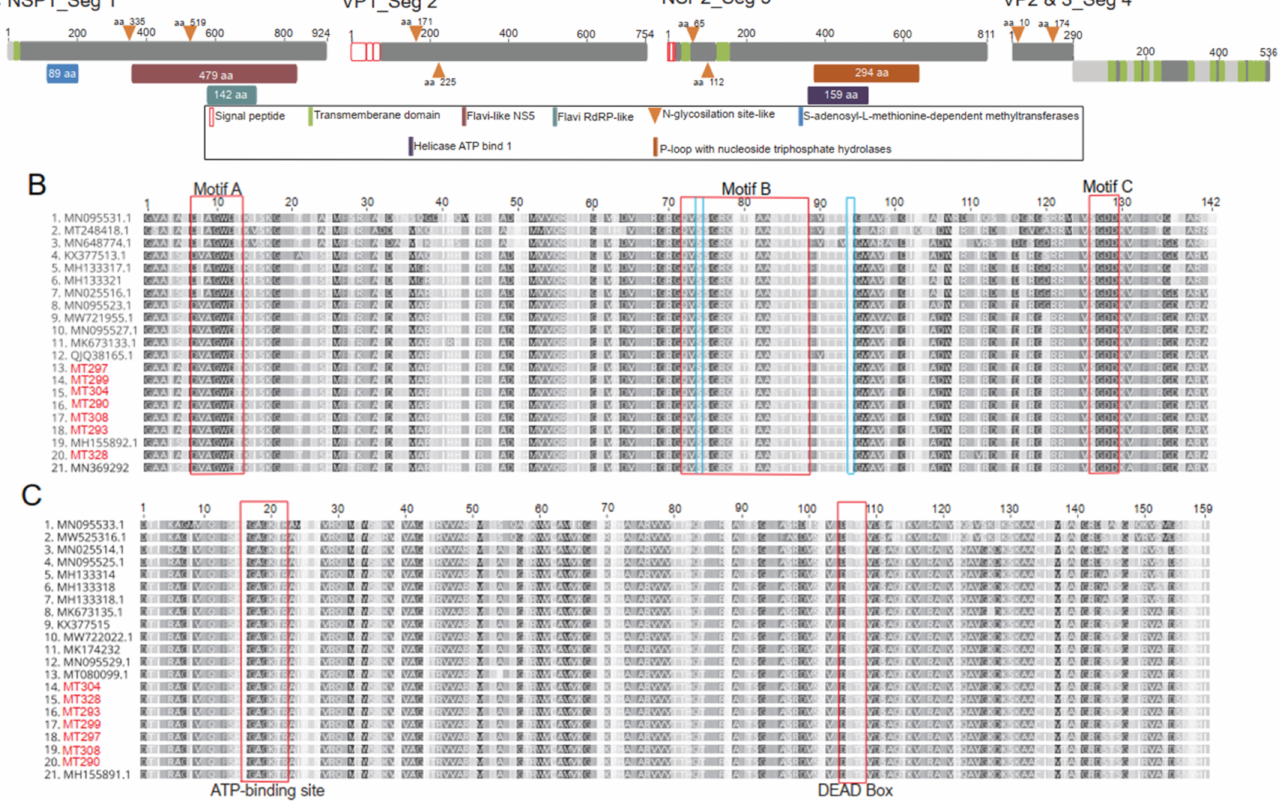
Figure 3. Genome structure of JMTV. ( A ) genome organization; grey regions represent non cyto- plasmic domains while light grey regions show cytoplasmic domains; ( B ) conserved JMTV RNA- dependent RNA polymerase; motifs A, B, and C represent highly conserved regions, light blue boxes highlight regions of functional significance; ( C ) protease/helicase motifs of JMTV and viruses identified in the present